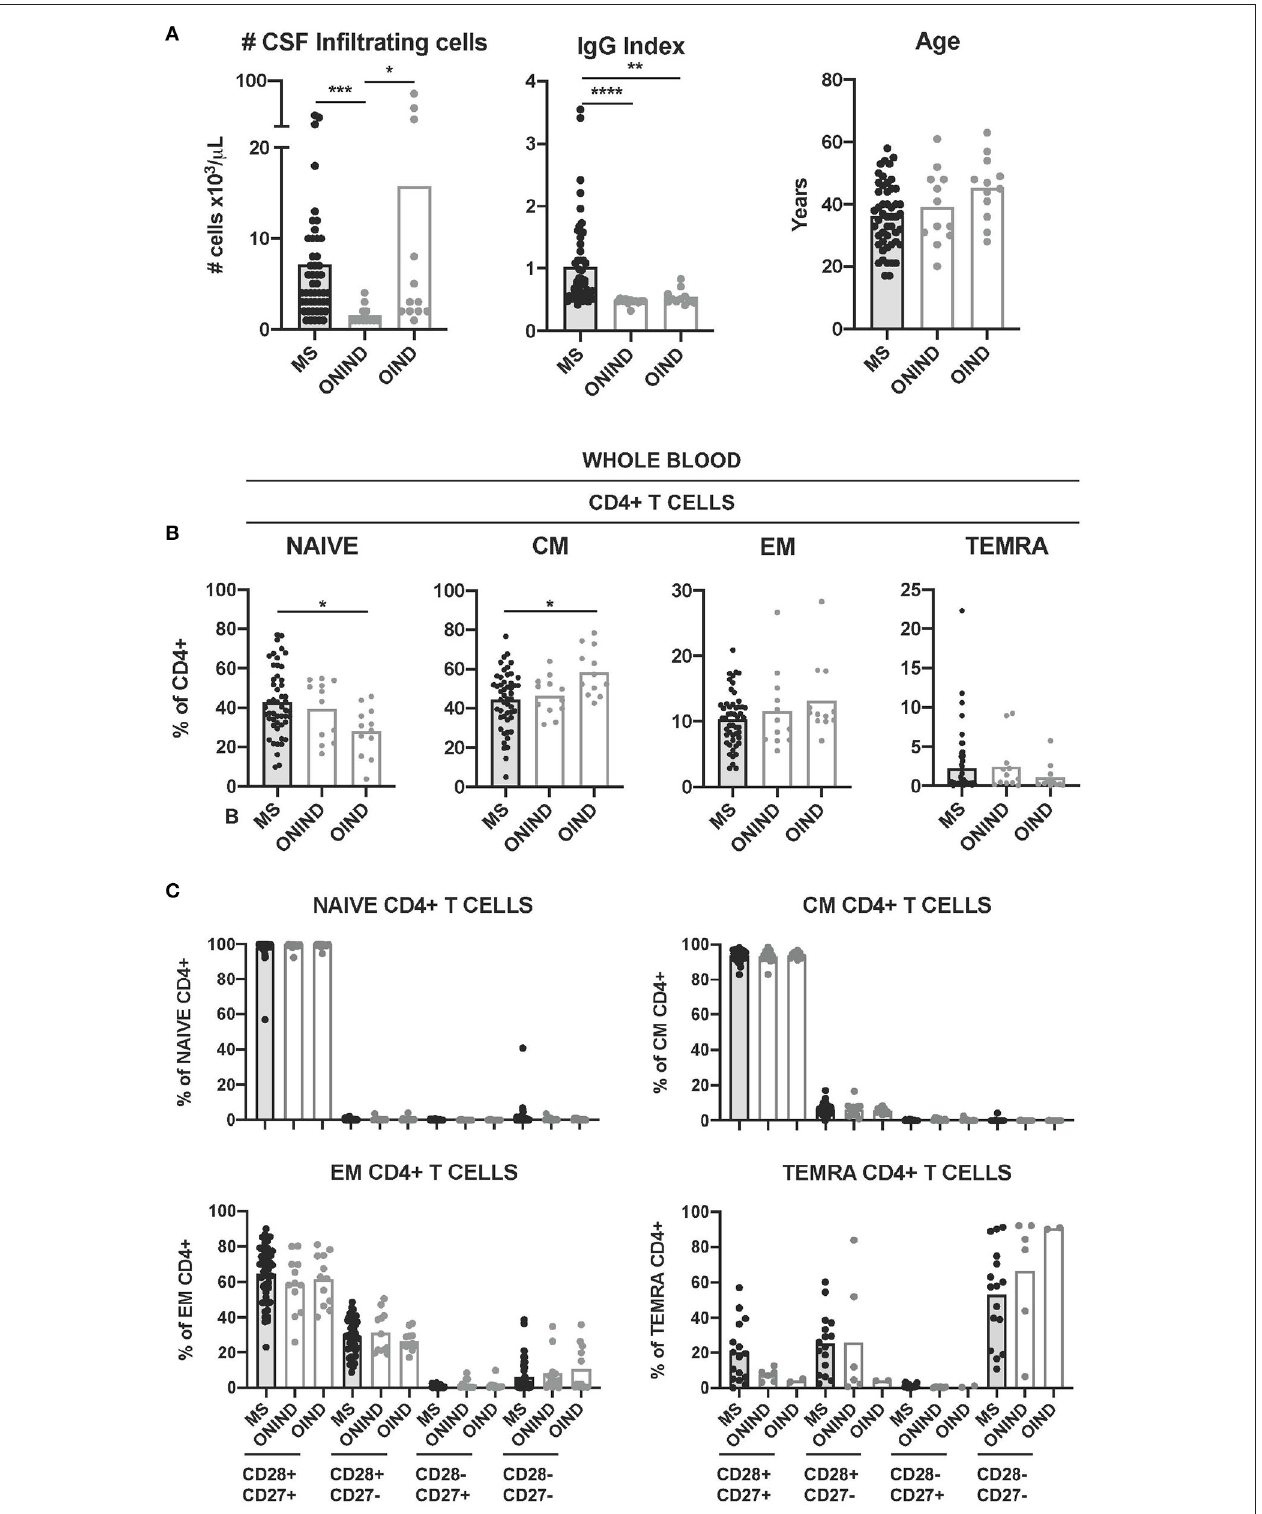
FIGURE 5 | Comparison of circulating CD4 + T-cell senescence between patients with MS and controls. (A) Graphs showing the number of CSF-infiltrating cells (left graph), IgG Index (middle graph) and age in years (right graph) in patients with MS ( n = 50) and control patients affected of other non-inflammatory